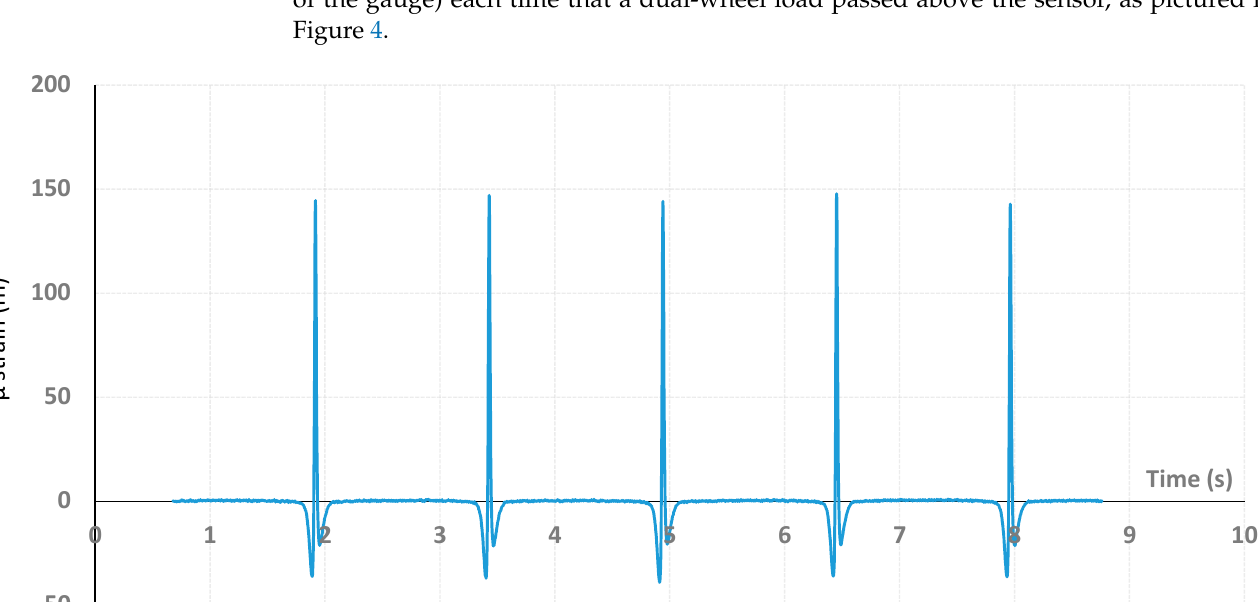
Figure 4. Example of µ strain signals recorded from the sensor as a function of time during spinning charging cycles.